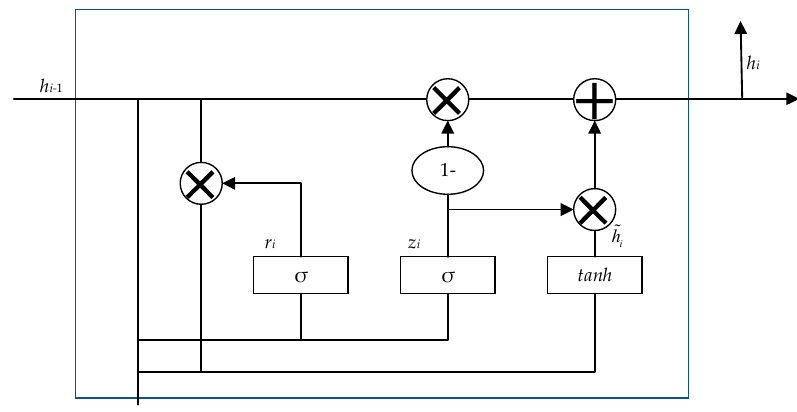
Figure 2. The architecture of the gated recurrent unit (GRU).